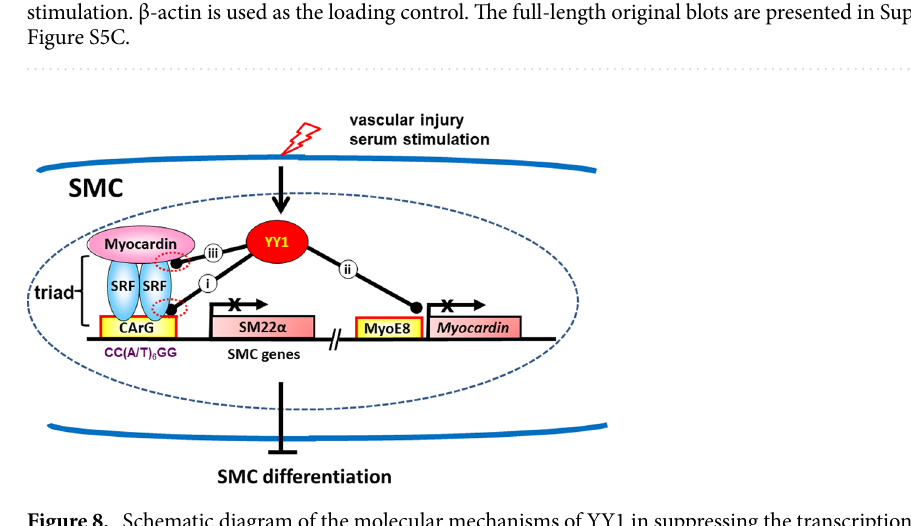
Figure 8. Schematic diagram of the molecular mechanisms of YY1 in suppressing the transcriptional activities of the MYOCD/SRF/CArG triad during SMC phenotypic modulation. The Myocardin/SRF/CArG box triad plays a critical role in coordinating gene transcription in SMC in response to developmental and pathogenic signals 2,4,5,40,42 . Our study here demonstrates that vascular injury or serum stimulation induces the expression of YY1 in SMCs to repress Myocardin/SRF/CArG box-mediated SMC-specific gene transcription through multiple mechanisms: (i) by inhibiting the binding of SRF to the CArG box in the SMC-specific promoter; (ii) by inhibiting the transcription activity of both the promoter and the enhancer (MyoE8) of Myocardin gene; and (iii) by competing with SRF for the binding to Myocardin protein. The drawing is created by contributing